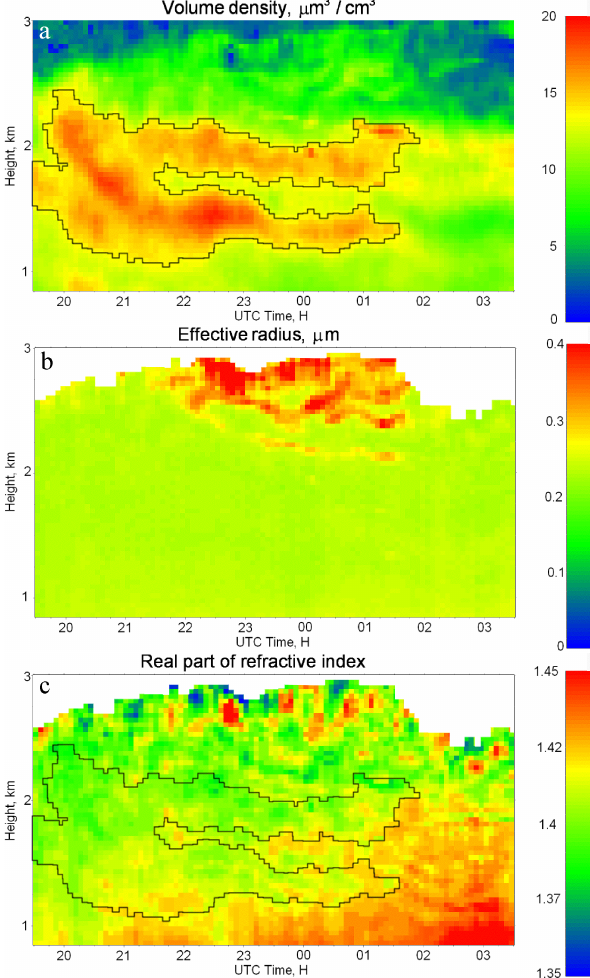
Fig. 7. Time-series of (a) particle volume density; (b) effective ra- dius; (c) real part of refractive index retrieved from measurements on 20 May